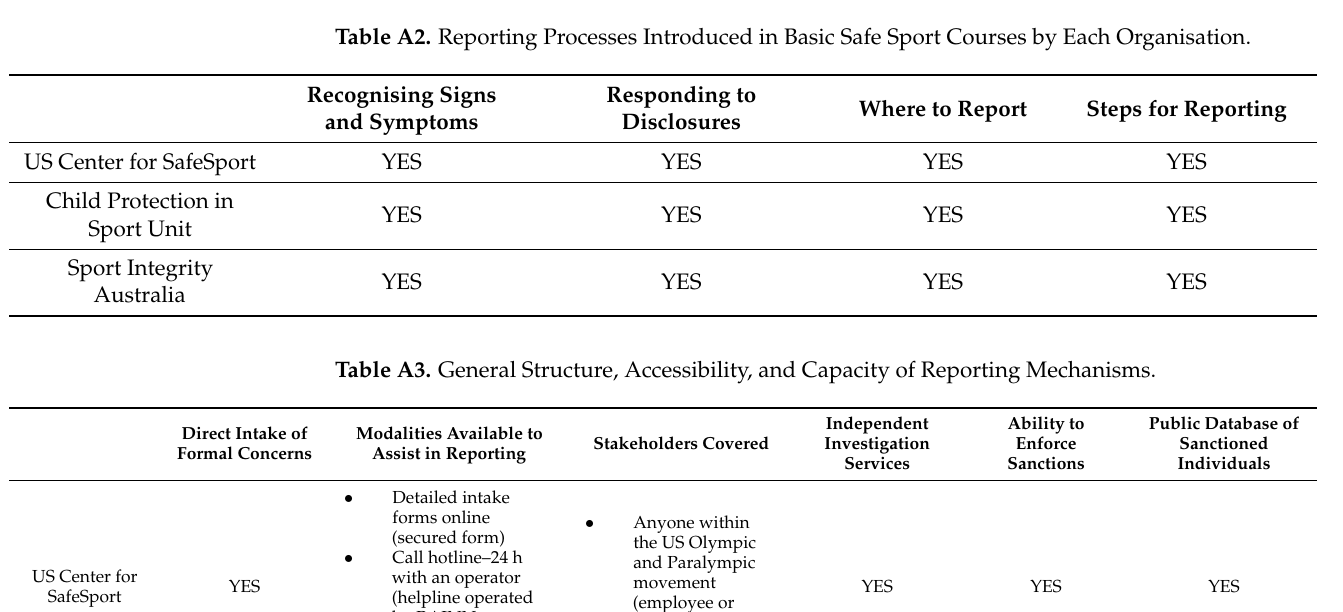
Table: i.: Is the concept mentioned in the course content? ii.: Does the course content define/describe the concept? iii.: Does the course content provide examples of what the concept looks like in practice? iv.: Does the course